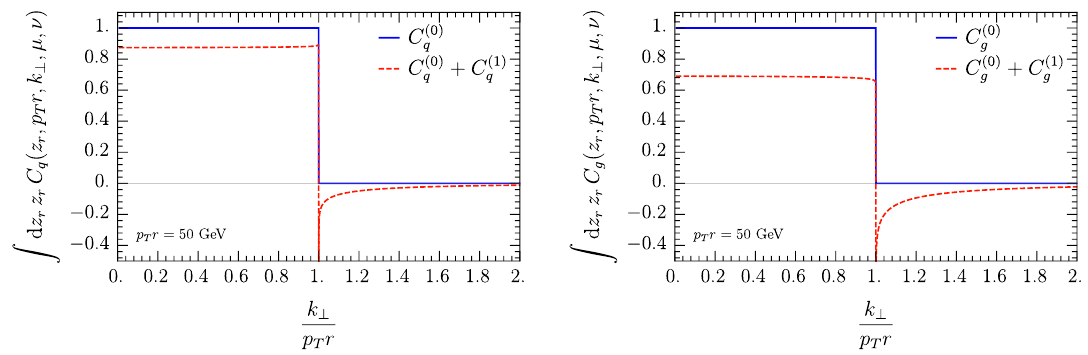
Figure 6 . The linear z r moment of the collinear function for quark jets (left) and gluon jets (right) at tree level (blue) and including one-loop corrections (red dashed), evaluated at the scales (cid:22) = p T r and (cid:23) = p T